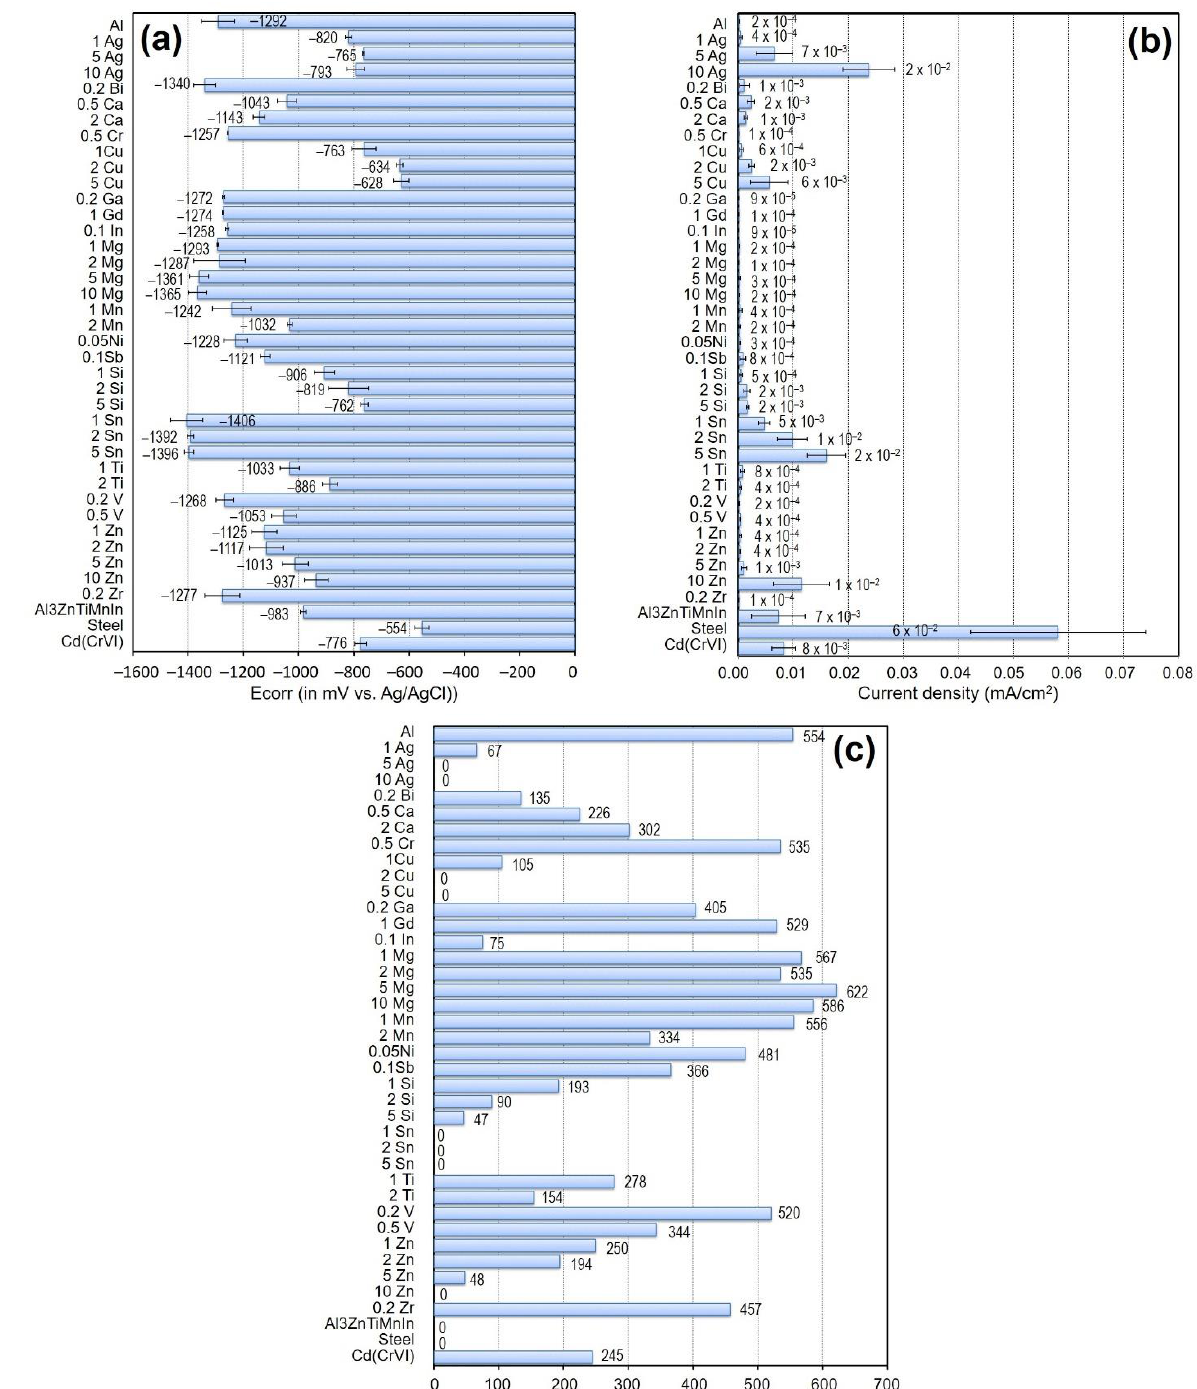
Figure 1. Corrosion properties of binary Al-based alloys measured in 3.5 wt.% NaCl: ( a ) corrosion potential (Ecorr), ( b ) corrosion current density and ( c ) passivation range. Additionally, mild steel, commercial sacrificial anode alloy (Al-3Zn-Ti-Mn-In) and a chromated Cd layer are included for comparison.